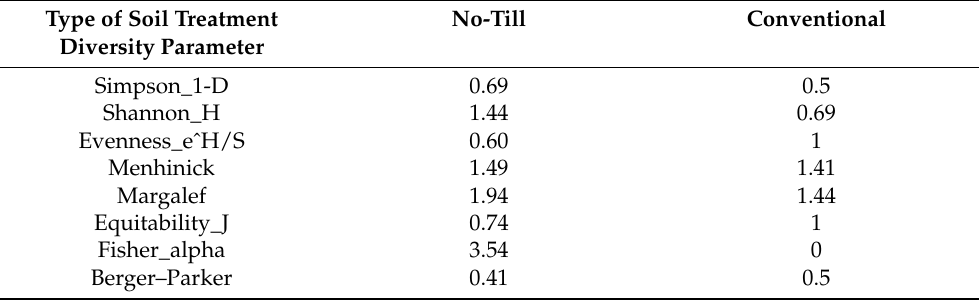
Table 8. General indicators of species diversity in spider (Aranei) communities depending on the type of tillage in 2017. There are no significant differences (permutation test).